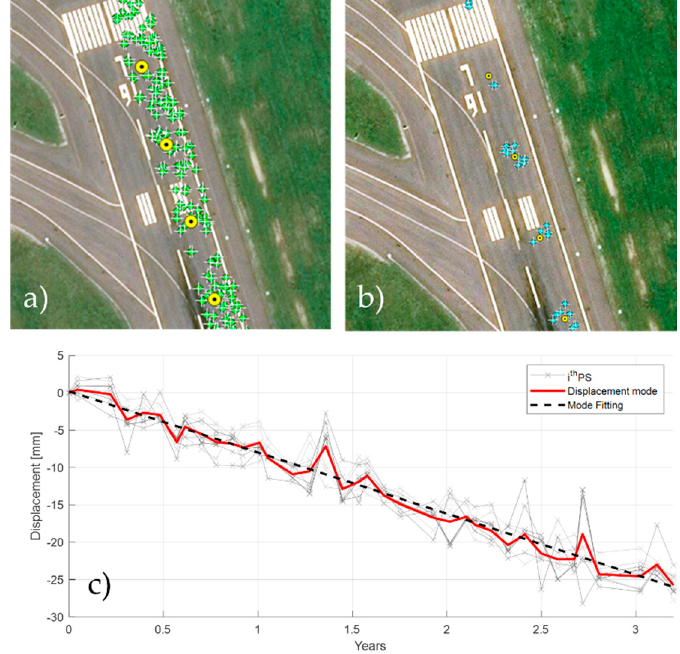
Figure 3. Scheme of SAR data processing: ( a ) visualisation of the whole PS (green) and levelling (yellow) datasets; ( b ) selection of PSs (blue) within a 10 m radius from each levelling point (yellow); ( c ) reconstruction of a single time series and deformation velocity starting from the PS sample.